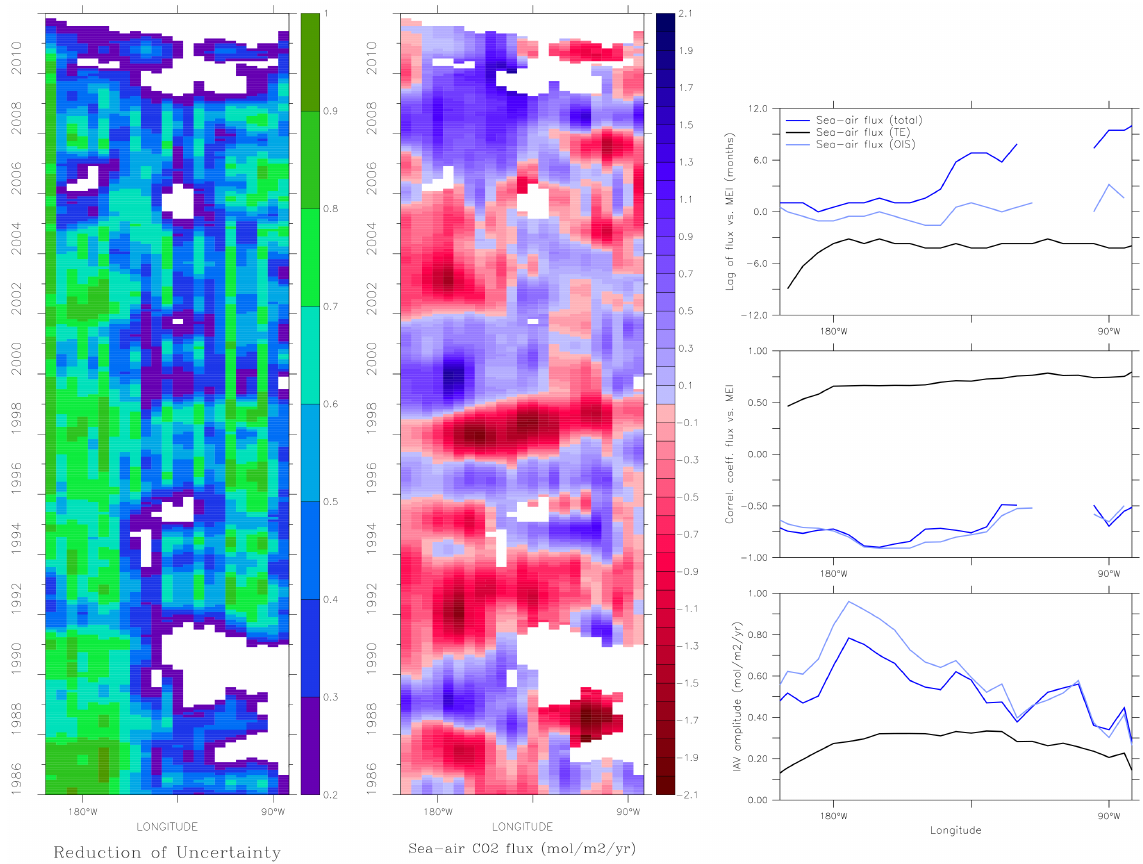
Figure 6. Sea–air CO 2 flux variability along the Equator in the Pacific (4 ◦ S–4 ◦ N average). Left: strength of the data constraint (RoU). Middle: interannual anomalies of sea–air CO 2 flux shown as Hovmöller plot (colour-coded over longitude (horizontal axis) and time (vertical axis); locations/periods with RoU < 0.2 left white). Right: statistical properties (calculated for 1993–2008): time lag at which the flux is most strongly correlated to El Niño (interannually filtered MEI; Wolter and Timlin, 1993) (upper panel, positive values mean that the flux trails the MEI); correlation coefficient at this time lag (middle panel); and temporal standard deviation of interannual flux anomalies (lower panel). In the correlation plots, insignificant correlations have been discarded. (The Supplement, Fig. S6 in Sect. S3, illustrates correlations and time lags again in a time series